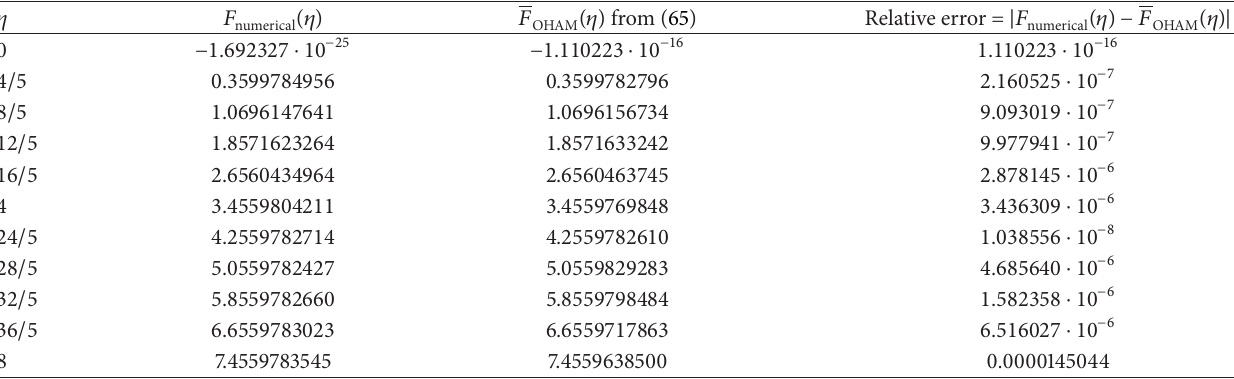
Table 19: Comparison between OHAM results given by (65) and numerical solutions for 𝛽 = 1.6 .